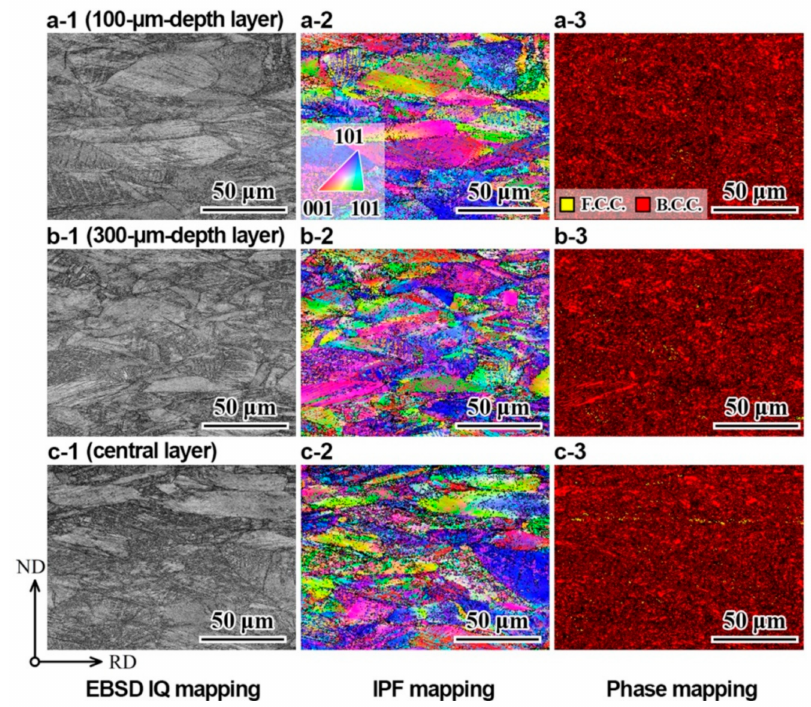
Figure 7. EBSD images of the GS2 sample after tensile testing at cryogenic temperature: ( a1 – a3 ) IQ, IPF and phase mappings for the layer with a depth of 100 µ m; ( b1 – b3 ) IQ, IPF and phase mappings for the layer with a depth of 300 µ m; ( c1 – c3 ) IQ, IPF and phase mappings for the central